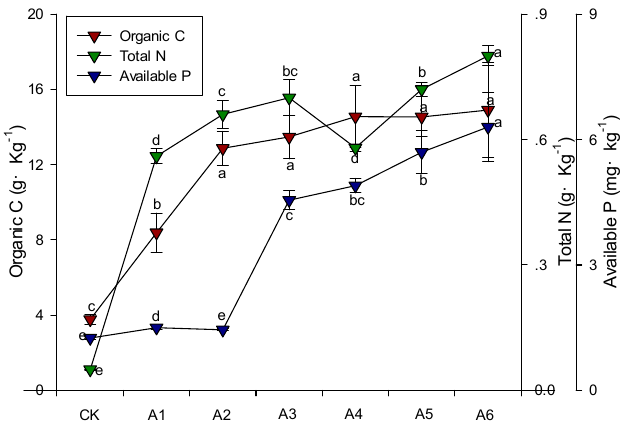
Figure 13. Relationship between poplar age and soil chemical indexes. Means with different letters indicate significant differences at p < 0.05. Vertical bars represent ± standard deviation.